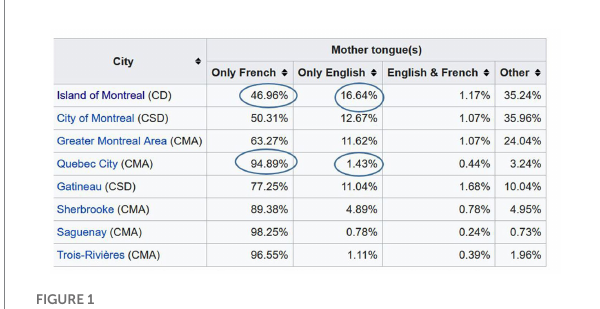
FIGURE 1 Census Profile from Statistics Canada (2011) showing relative numbers of French (see column “Only French”) and English speaking communities (see column “Only English”). My emphasis of differences between numbers of speech